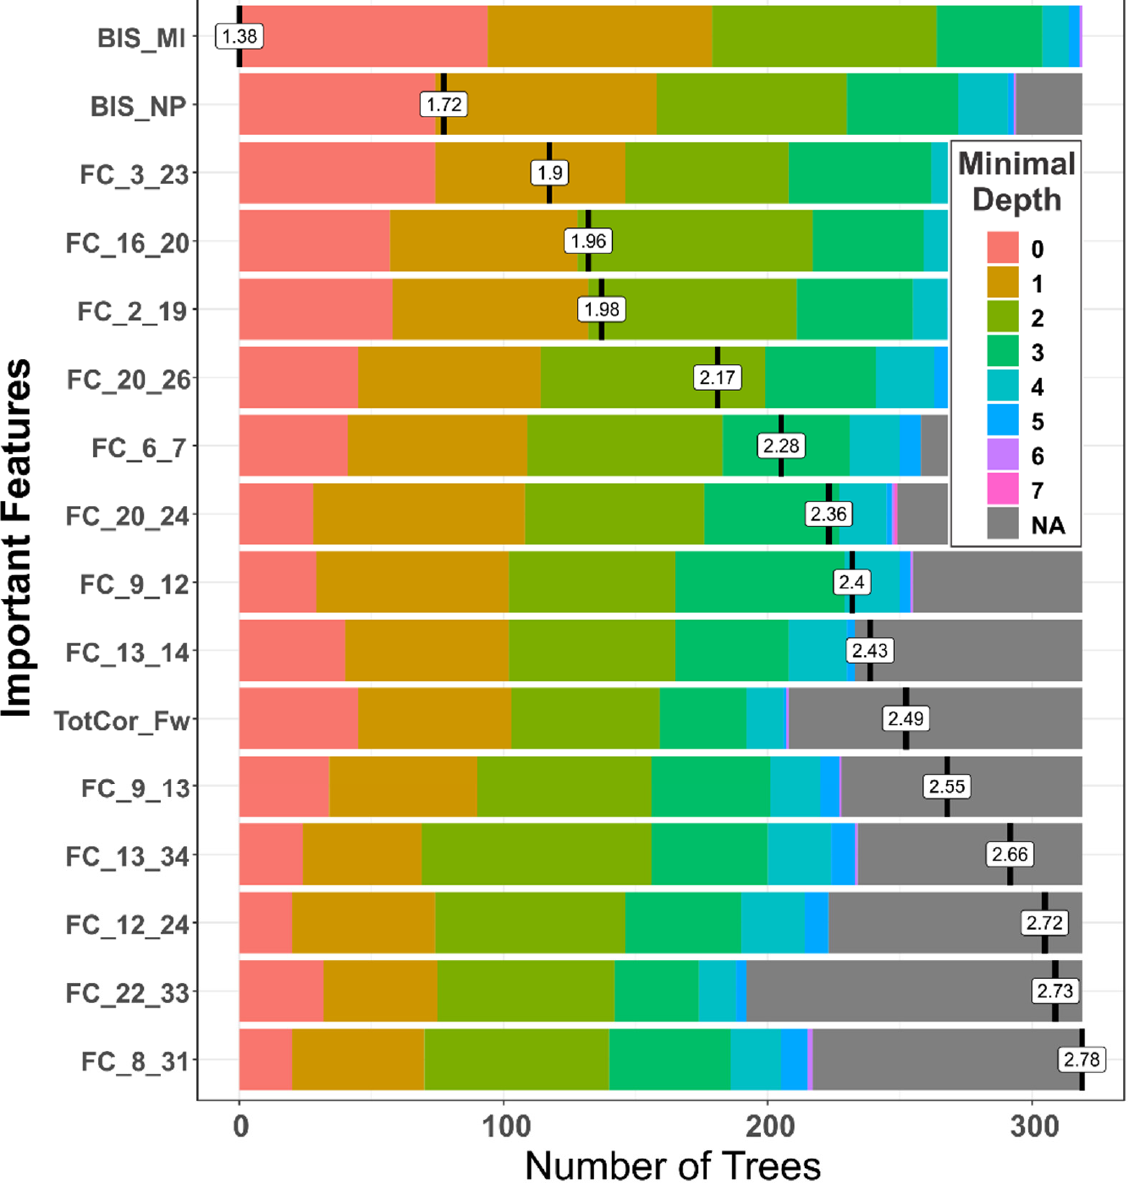
Figure 4. The distribution of minimal depth among the trees of the forest for the significant variables is shown in different colors for each level of minimal depth. The mean minimal depth in the distribution for each variable is marked by a vertical black bar overlapped by a value label inside a box. Based on the mean minimal depth values, the importance list comprised 2 BIS scores, 13 FC, and 1 neuropsychological score, which contributed to the RF classification of AUD and CTL individuals. The lower mean minimal depth of a feature represents a higher number of observations (participants) categorized in a specific group based on the feature. The number of trees for a feature represents the total number of decision trees in which a split occurs on the feature (see Table 2 for details about the ROI numbers (1–34) represented in the FC variables) .